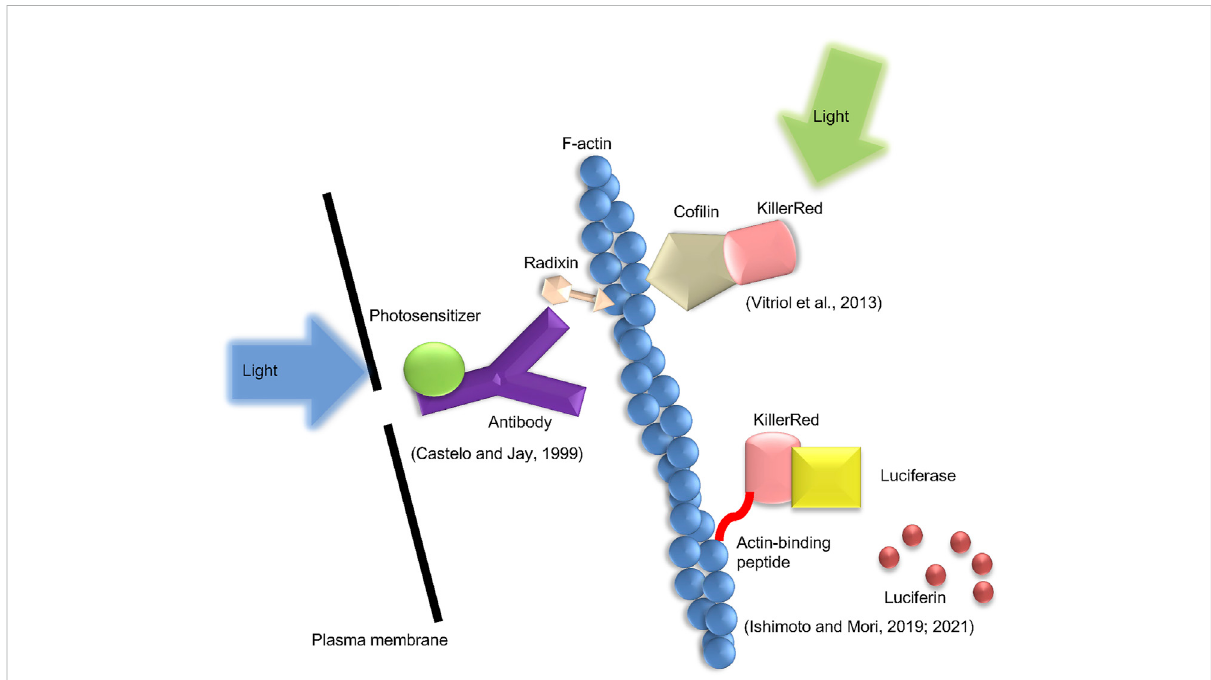
FIGURE 2 TypesoftheCALImethodpresentedinthismini-review.ThreetypesofCALImethodwhichwereintroducedinthetextareshown.Themethod by Castelo and Jay uses an anti-radixin antibody labeled with a photosensitizer and generates ROS by applying excitation light. Vitriol et al. fuse KillerRed with co fi lin and express it in cells to induce ROS action on F-actin. Ishimoto et al. generate ROS using the luciferin-luciferase reaction instead of excitation